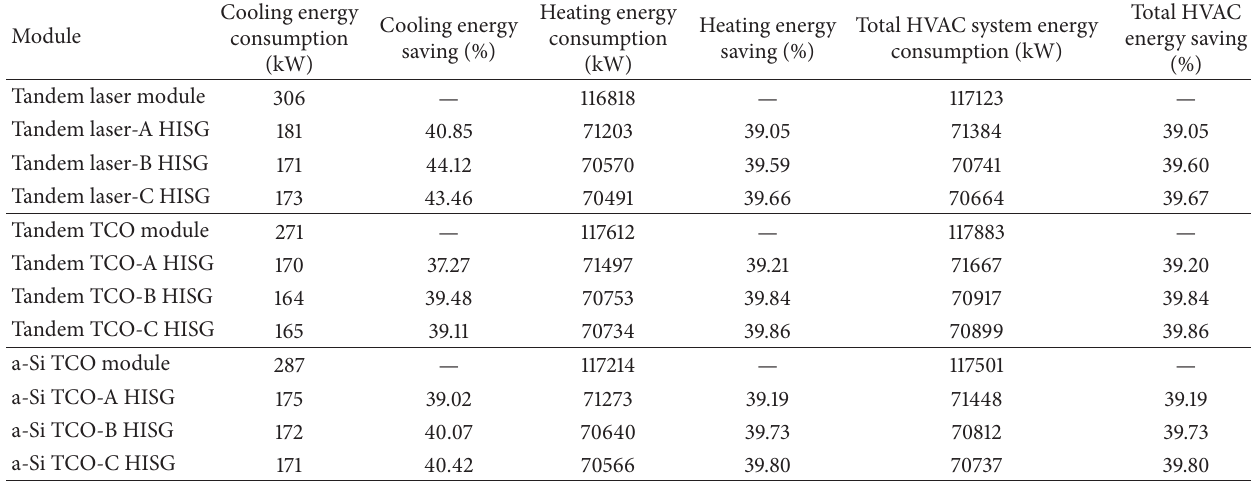
Table 9: Simulation results for energy consumption of HVAC systems for the building body in London, UK.